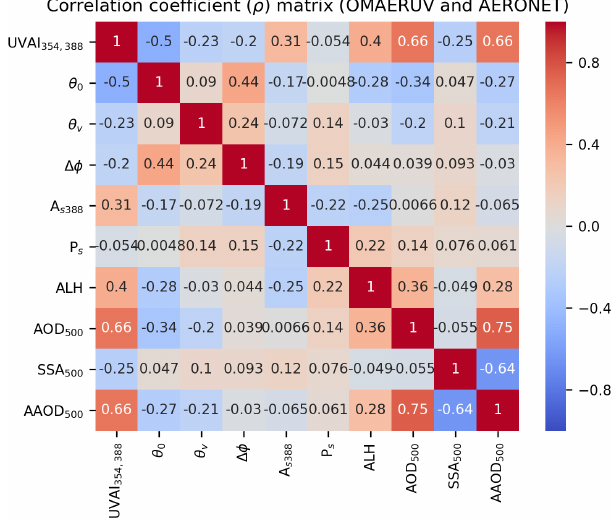
Figure 6. Spearman rank correlation coefficient matrix ( ρ ) of pa- rameters in the OMAERUV–AERONET joint data